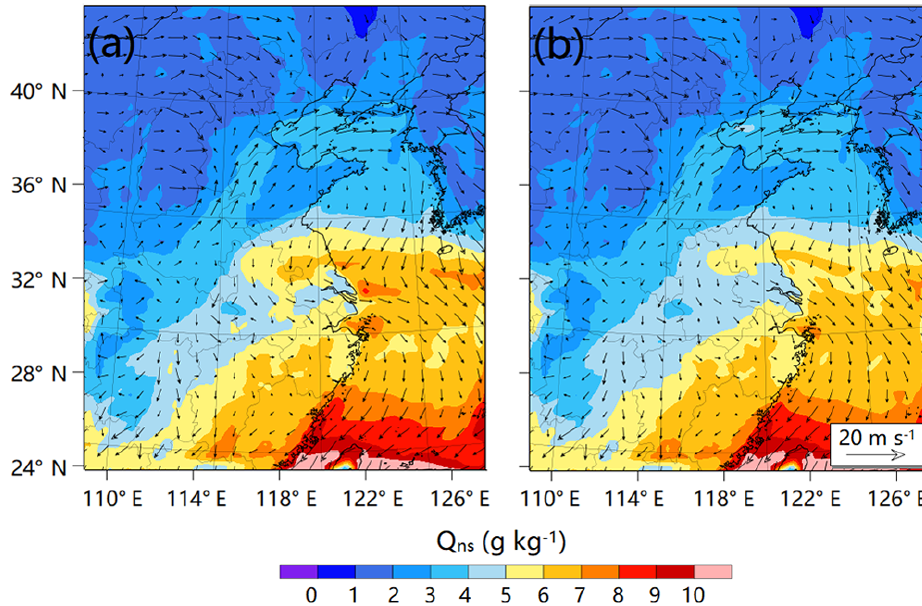
Figure 9. Spatial distribution of Q ns (gkg − 3 ) and V ns (ms − 1 ) from EXP_CTL (a) and EXP_NOBC (b) at 14:00LST on 6